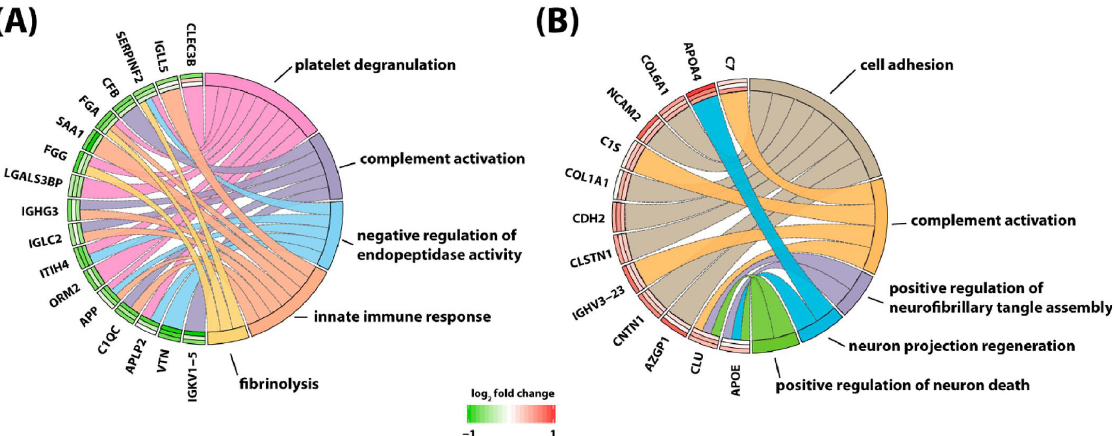
Figure 2. Protein to biological pathway linkages for proteins in two clusters, ( A ) cluster 1 and ( B ) cluster 2, based on hierarchical clustering analysis. The significantly altered proteins (ANOVA, adjusted p value < 0.1) are linked to pathways as color-coded ribbons. Green-to-red rectangles next to the altered proteins indicate the magnitude of the log2 fold change (FC), where the inner layer represents the FC of week 1 in comparison with week 5, the middle layer represents the FC of week 1 in comparison with weeks 10 − 14, and the outer layer represents the FC of week 1 in comparison with weeks 24 − 28. Figure is reprinted from Yu et al., Isobaric Labeling Strategy Utilizing 4-Plex N, N-Dimethyl Leucine (DiLeu) Tags Reveals Proteomic Changes Induced by Chemotherapy in Cerebrospinal Fluid of Children with B-Cell Acute Lymphoblastic Leukemia. J. Proteome Res. 2020, 19, 2606–2616 [79]. Copyright (2020) American Chemical